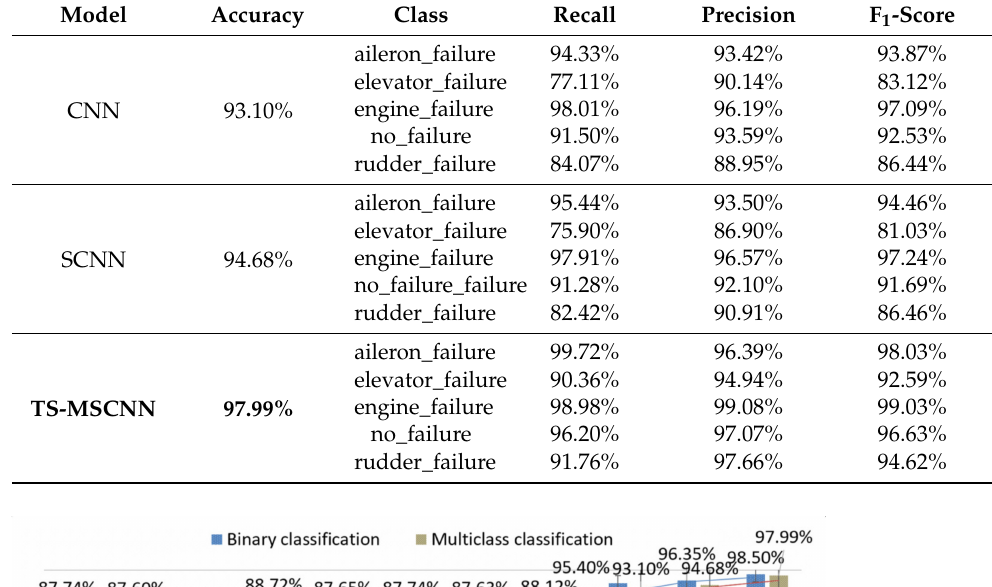
Table 6. The detailed performance of CNN, SCNN, and TS-MSCNN.